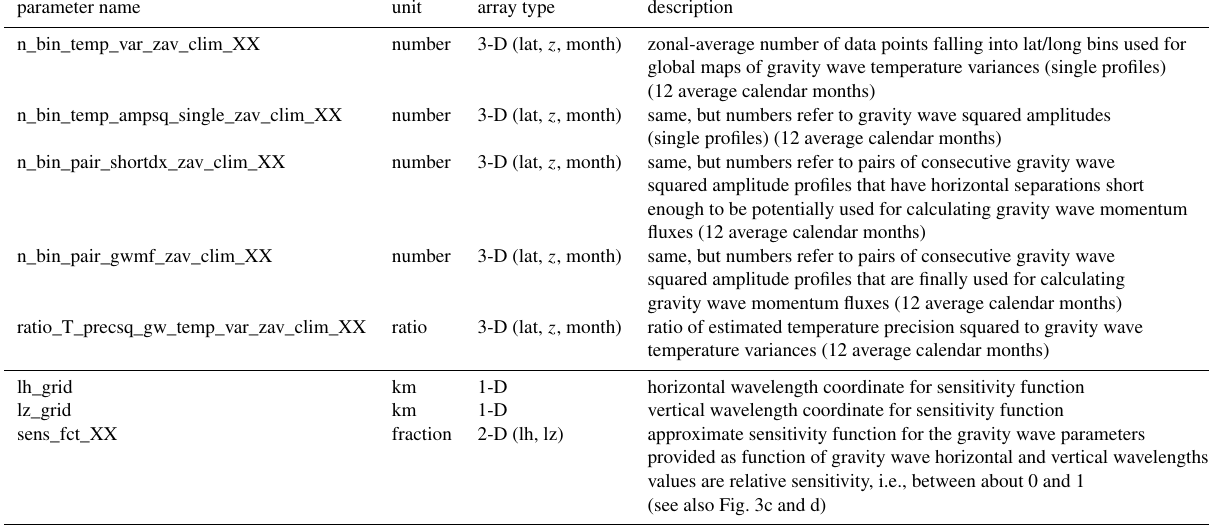
Table 4. Additional diagnostics for climatological zonal-average gravity wave parameters provided in the GRACILE gravity wave climatol- ogy data file. In the parameter names “XX” is to be replaced by either “SABER” or “HIRDLS”. Grid points not covered by data are flagged with − 999. Also provided are approximate sensitivity functions. The latitude–altitude grid is the same as for the parameters listed in Table 3.